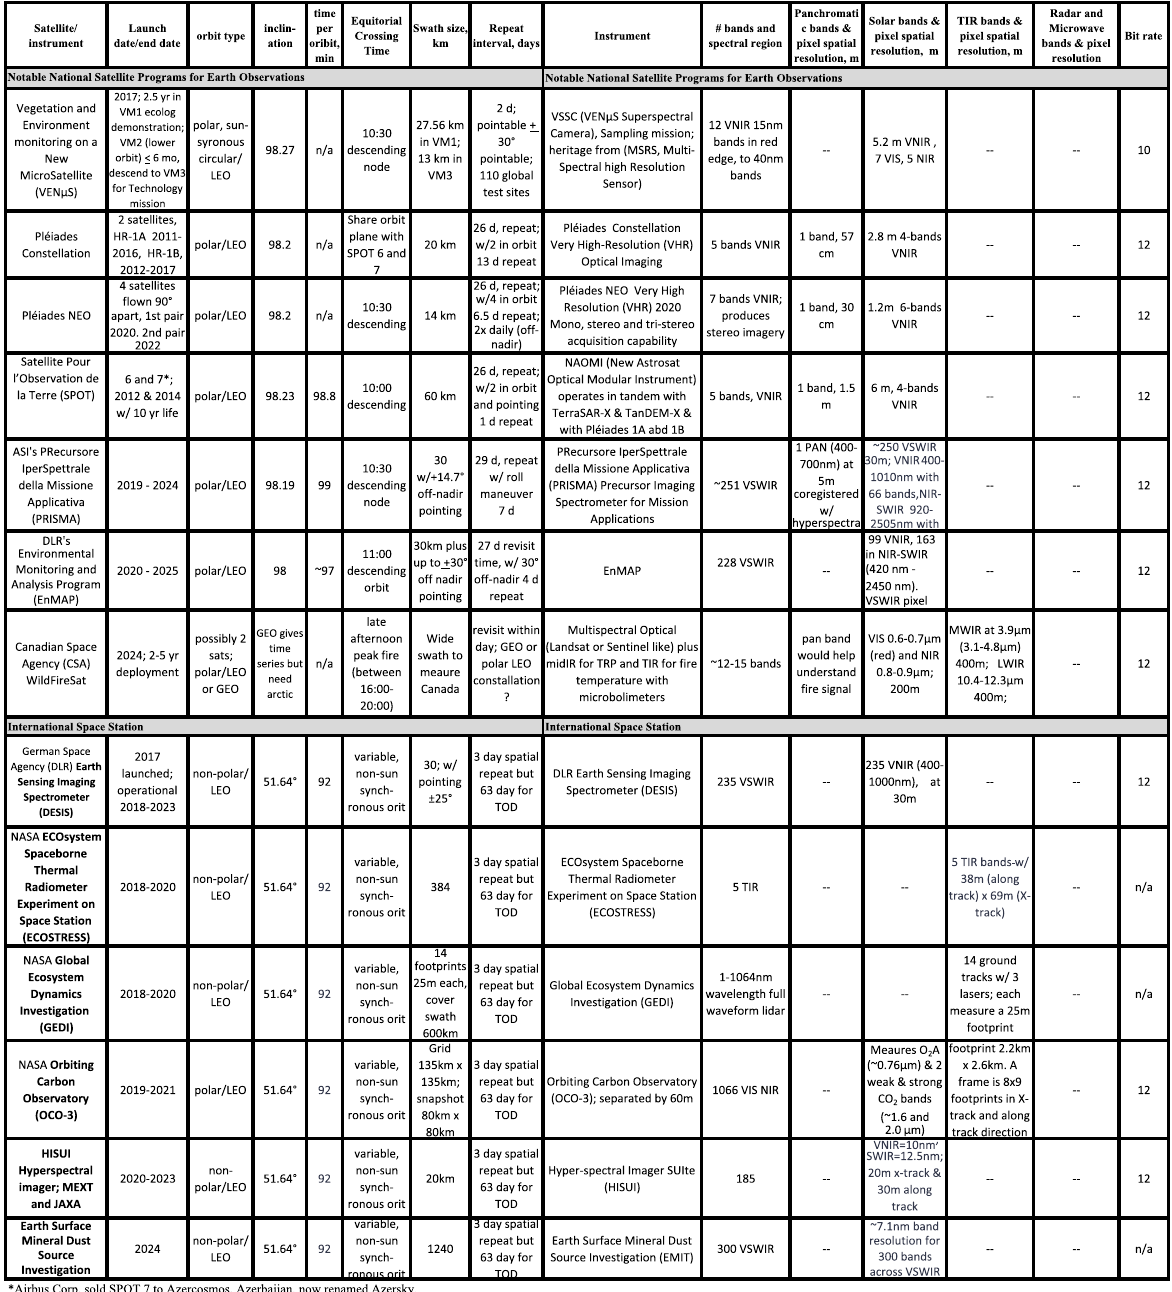
Table 4 Notable other satellite programs for Earth observation, including the International Space